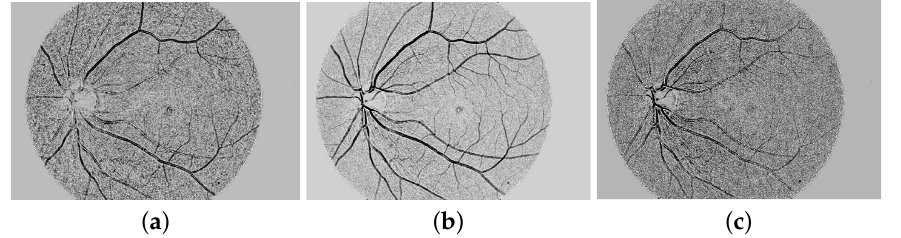
Figure 4. Morphological THBH method for irregular illuminations ( a ) Red ( b ) Green and ( c ) Blue, Channels